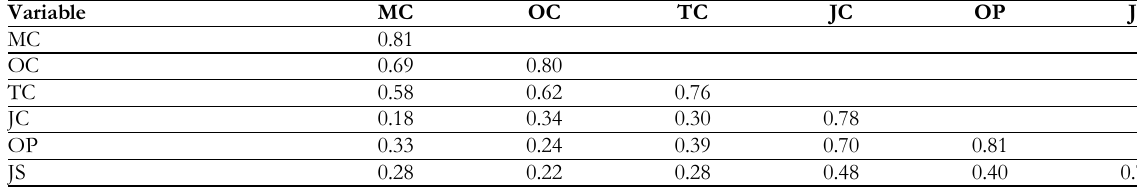
Table 4. Discriminant Validity of the Research Model Variable